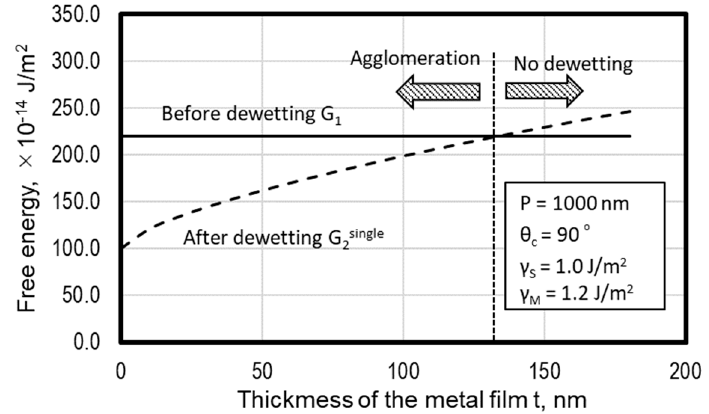
2single as calculated by Equation (4) and